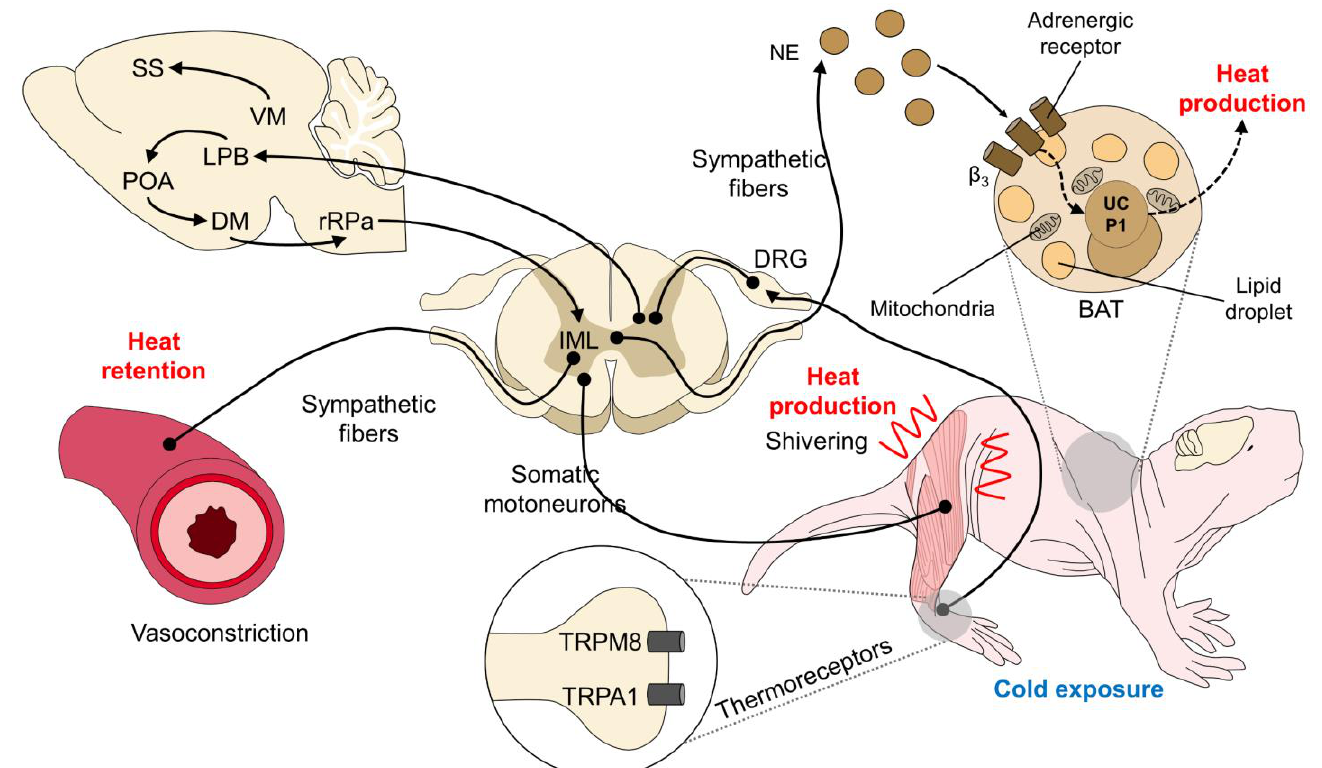
Figure 1. Neonate compensatory mechanisms in response to hypothermia. In newborns (illustrated by a naked mole ( Heterocephalus glaber ) in this figure), when the peripheral receptors responsible for the thermal sensation of cold are activated (e.g., TRPM8 and TRPA1), a neuronal response is generated that involves spinal structures (DRG) and the brain. In the brain, the thermoregulatory center (POA) receives the signal from the LPB. The POA has connections to the DMH, which, in turn, is connected to the rRPA and the IML neurons. Once in the spinal cord, two responses are produced through sympathetic efferents. Firstly, the innervation of blood vessels generates vasoconstriction and heat retention; conversely, the sympathetic release of NE acts on the BAT adrenergic receptors to produce heat. An additional response is shivering, a heat-generating process that depends on the spinal cord’s somatic motoneurons and their terminals. These mechanisms promote the production or retention of heat to protect the body from the consequences of hypothermia. BAT: brown adipocyte tissue; DMH: dorsomedial hypothalamus; DRG: dorsal root ganglion; IML: intermediolateral nucleus; LPB: lateral parabrachial nucleus; NE: norepinephrine; POA: preoptic area of the hypothalamus; rRPa: rostral raphe pallidum; SS: somatosensory cortex; UCP1: uncoupling protein 1; VM: ventromedial